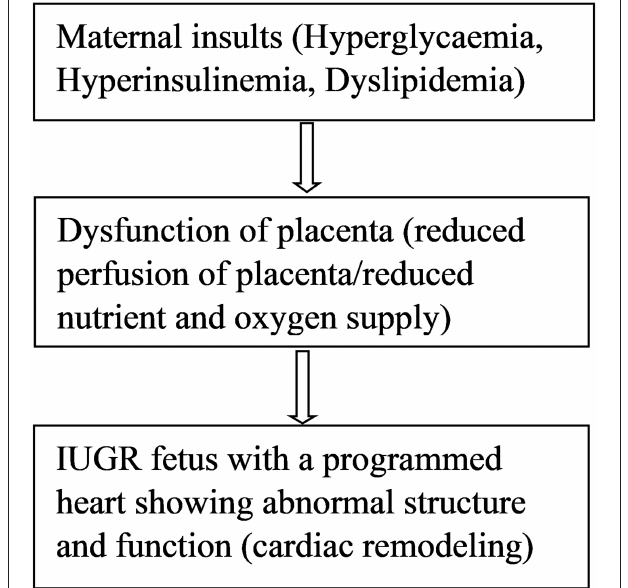
FIGURE 1 | Maternal insults result in placental dysfunction, IUGR, and cardiac